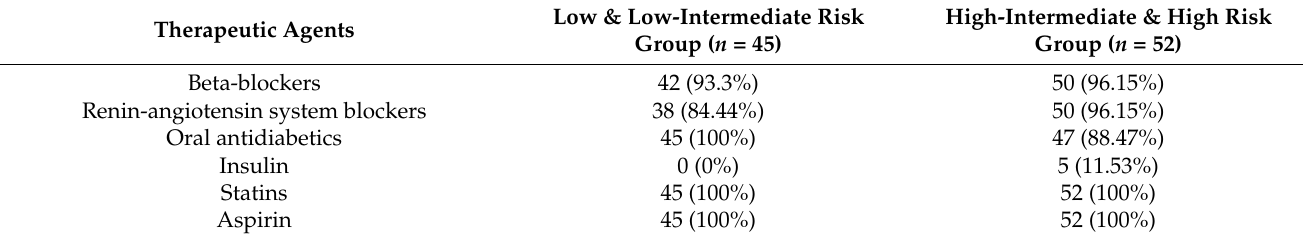
Table 3. Pharmacological